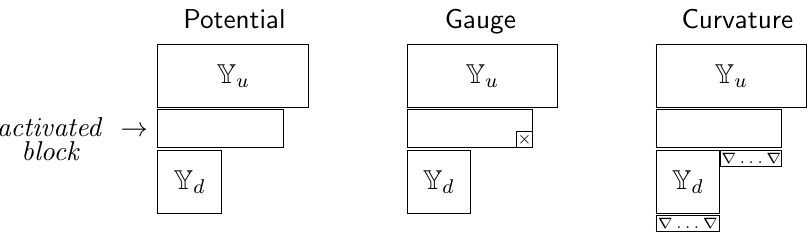
Figure 2 . Young diagrams corresponding, from left to right, to a mixed-symmetry massless (cid:12)eld, its gauge parameter acting in the isolated middle block with the cross indicating the removed cell, and (cid:12)nally its curvature built by acting with derivatives in the same block. Y u and Y d represent arbitrary Young diagrams that can be glued respectively above (up) and below (down) the middle